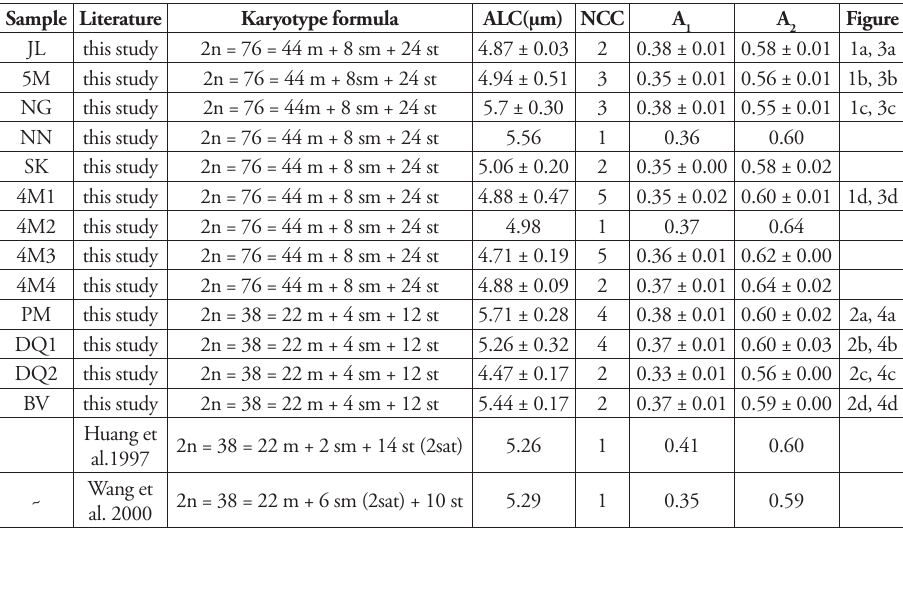
= karyotype intrachromosomal asymmetry index and A 1